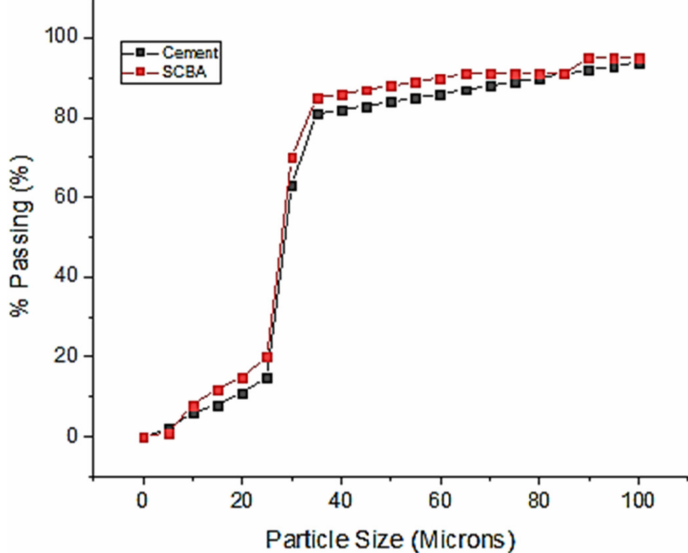
Figure 1. Particle size distribution of SCBA and cement.